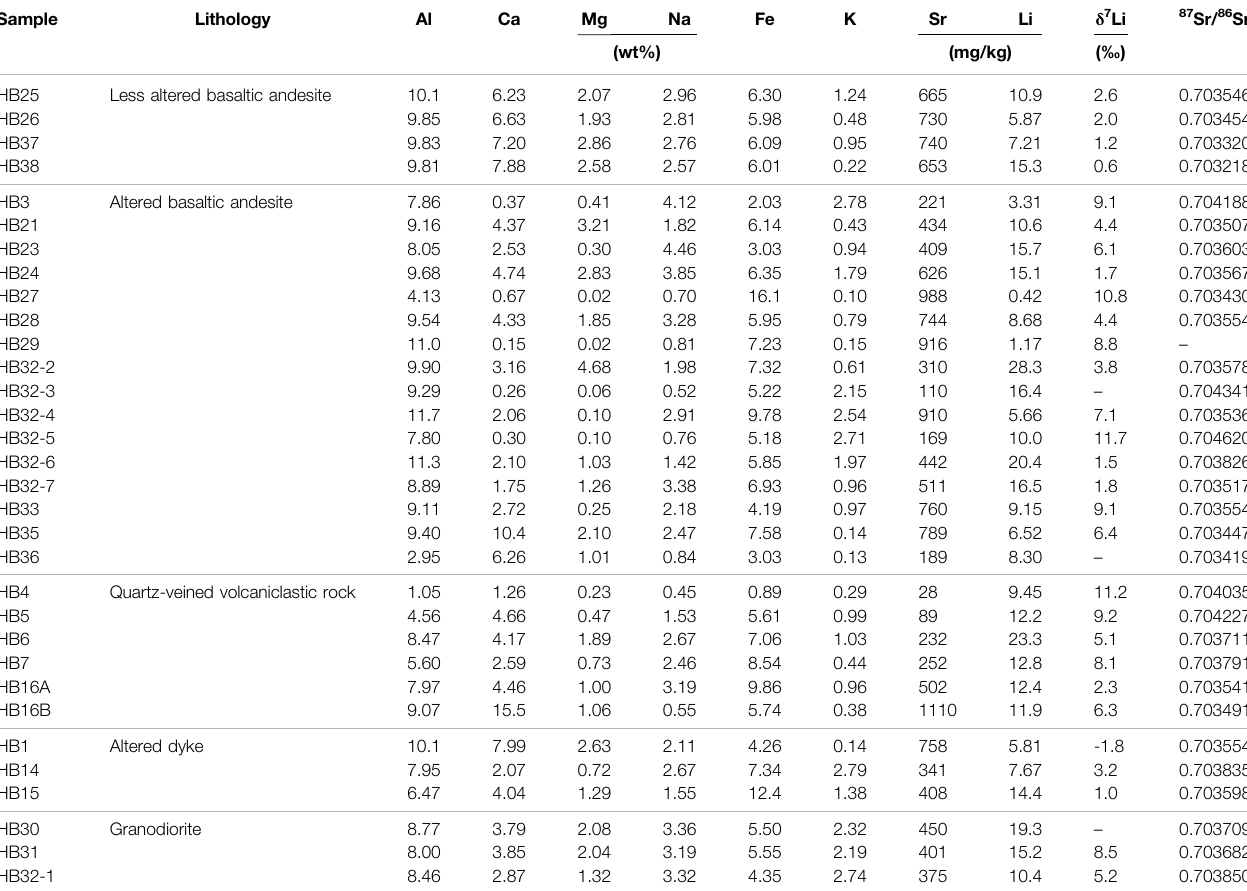
TABLE 4 | Elemental and isotopic compositions for